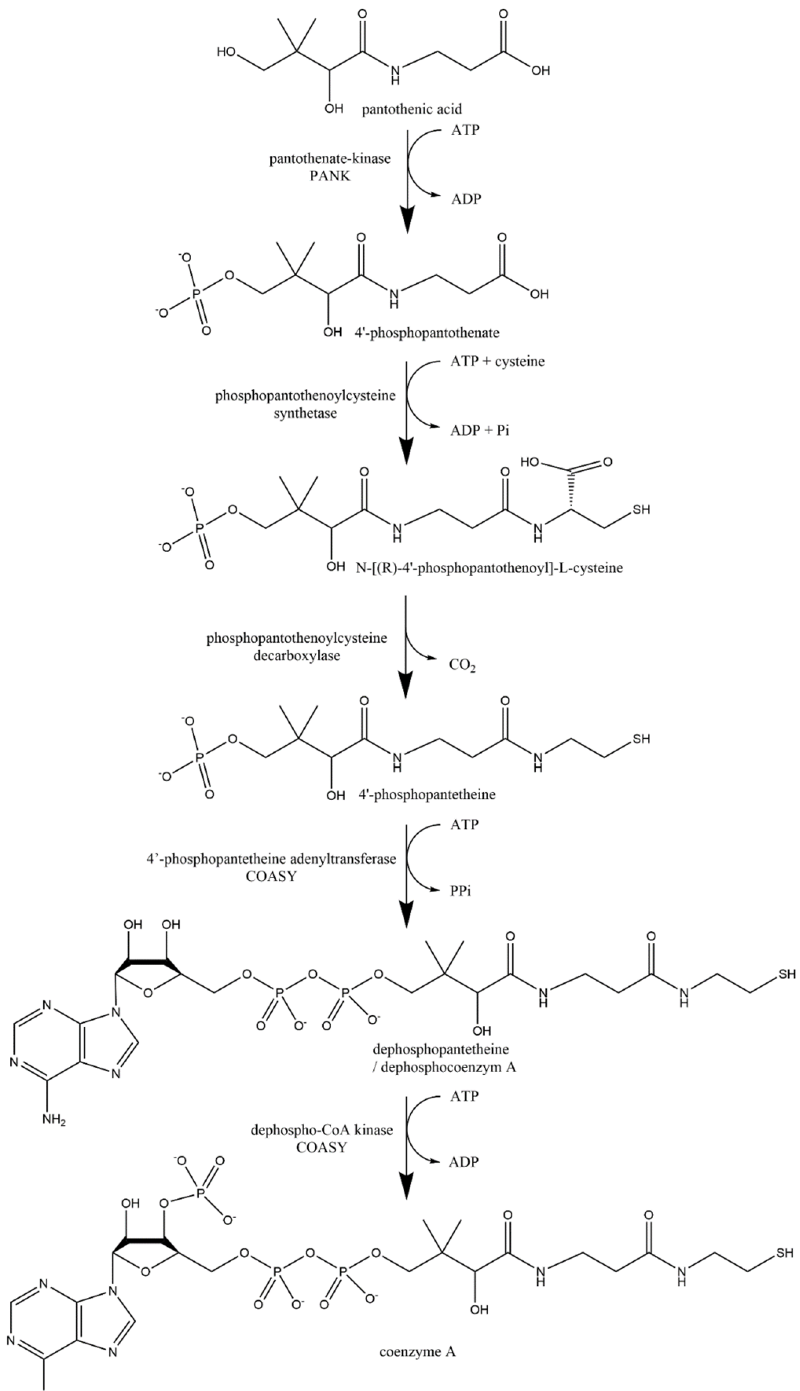
Figure 16. CoA biosynthesis. The five ‐ step pathway starts with phosphorylation of pantothenic acid to 4 ′‐ phosphopantothenate by pantothenate ‐ kinase (PANK). Then, 4 ′‐ phosphopantothenate condensates with cysteine. This reaction is catalyzed by phosphopantothenoylcysteine synthetase and gives rise to N ‐ [(R) ‐ 4’ ‐ phosphopantothenoyl] ‐ L ‐ cysteine. This product is subsequently decarboxylated in presence of phosphopantothenoylcysteine decarboxylase to generate phosphopantetheine. Last two steps consist of phosphorylation of 4 ′‐ phosphopantetheine to form dephosphopantetheine and phosphorylation of 3 ′‐ hydroxy group of ribose to form CoA. Both reactions are catalyzed by an enzyme called COASY, which exhibit two enzymatic activities: 4 ′‐ phosphopantetheine adenyltransferase (catalyzes the fourth reaction) and dephospho ‐ CoA kinase (catalyzes the fifth reaction).